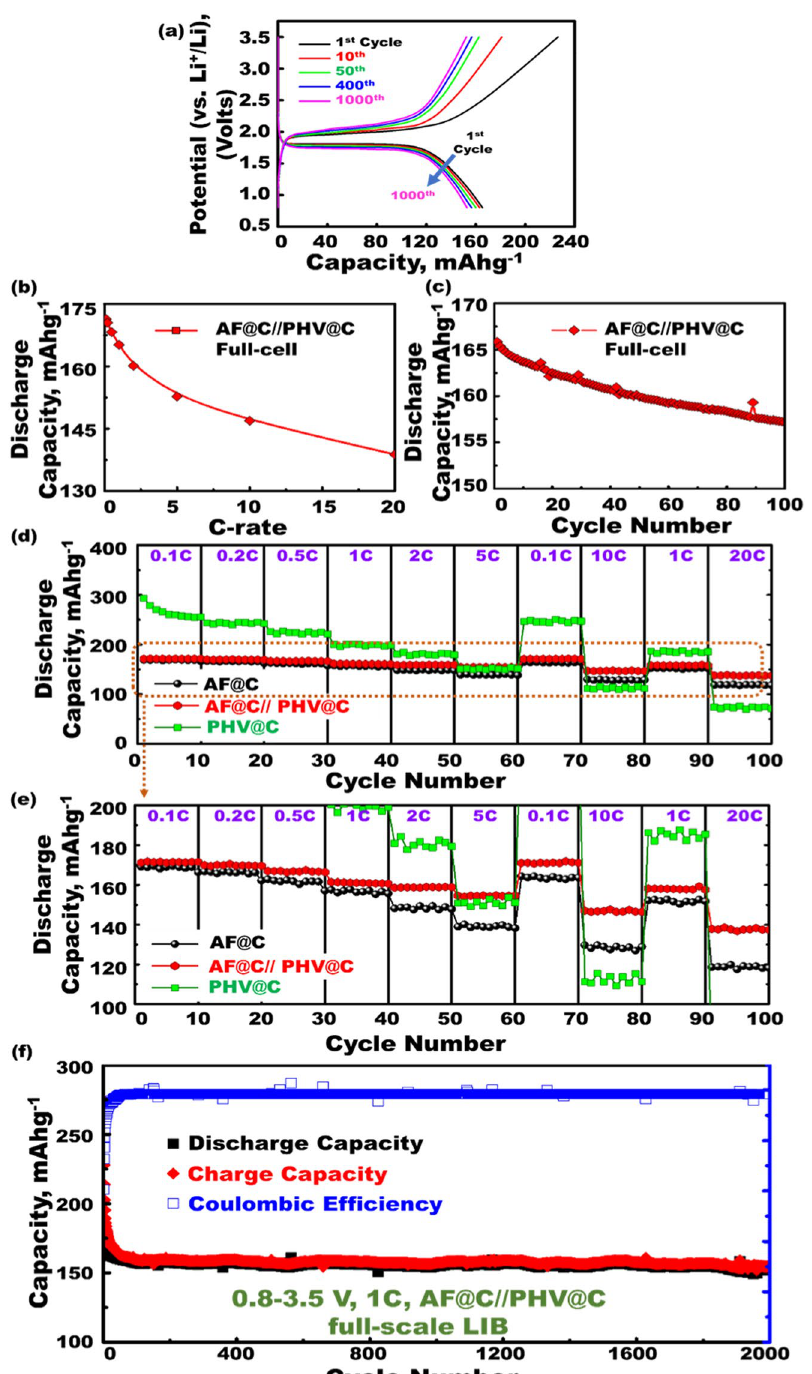
Figure 6. ( a ) Charge–discharge voltage-capacity profiles of AF@C//PHV@C meso-geodesics full-scale LIBs during long-term galvanostatic cycle between 0.8 and 3.5 V at constant current rate of 1 C and room temperature. ( b ) Behavior of specific discharge capacity in mAhg − 1 versus current C rates at 0.1, 0.2, 0.5, 1, 2, 5, 10, and 20 C and between 0.8 and 3.5 V for the built-in super-hierarchical heterogeneous open geode AF@C (cathode)//anatase TiO2 meso/macro pore spheres PHV@C (anode) full-scale LIB model. ( c )